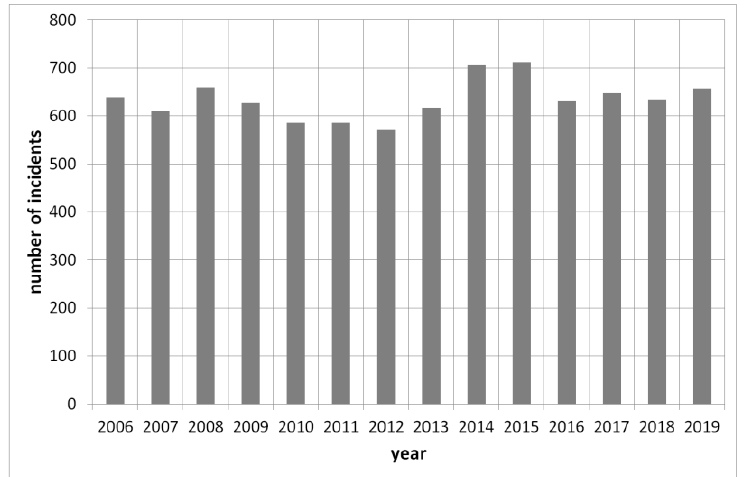
Figure 4. Number of incidents per year in the USA.